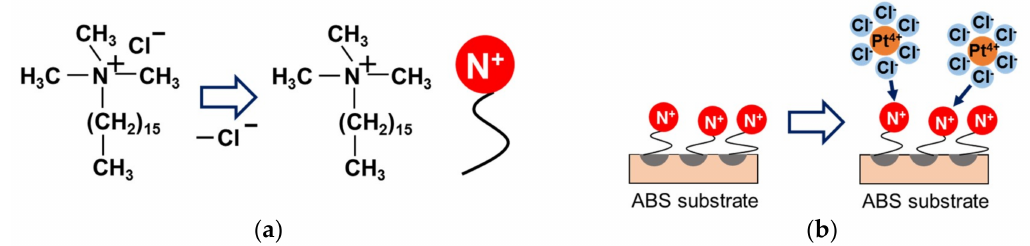
Figure 8. ( a ) Chemical formula of the surface charge controller (hexadecyltrimethylammonium chloride) and ( b ) schematic of electrostatic interactions between the surface charge controllers and Pt precursors (PtCl 62 − ).